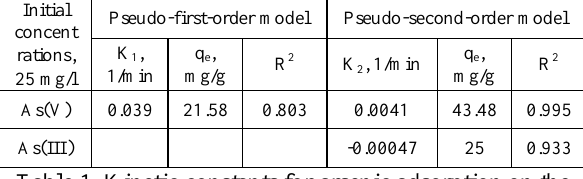
Table 1. Kinetic constants for arsenic adsorption on the ferrihydrite adsorbent.As shown in the table, the result of the study is approved